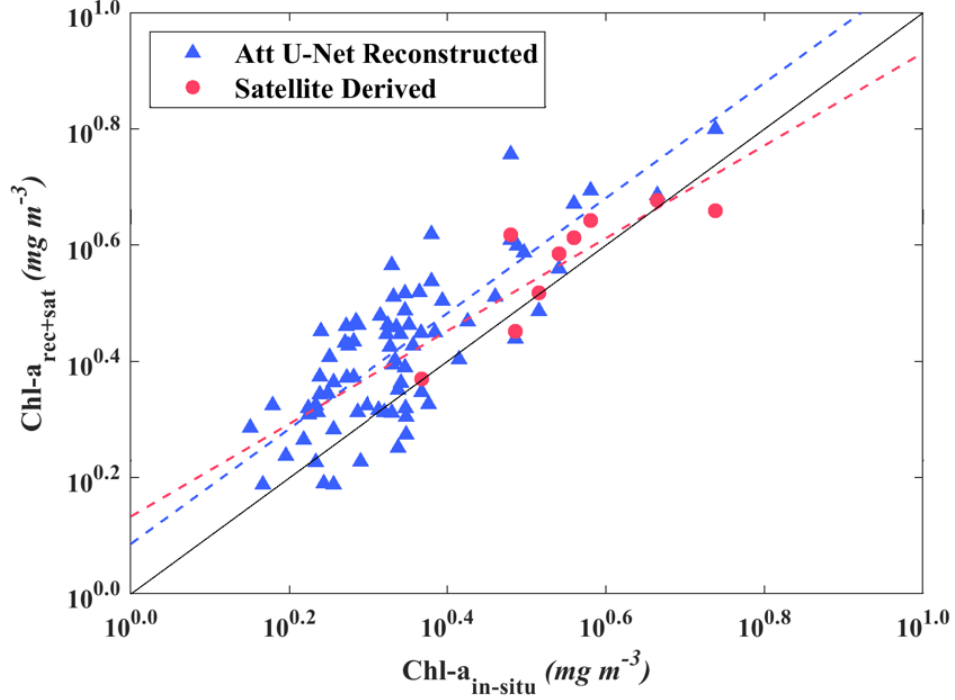
Figure 7. Comparison of the in−situ C chla and the reconstructed C chla . The dash line represents the fitted lines for the corresponding scatter plots. Table 2. Relationship between the in-situ C chla and the reconstructed (satellite-derived). The RMSD and Bias are in log 10 mg · m − 3